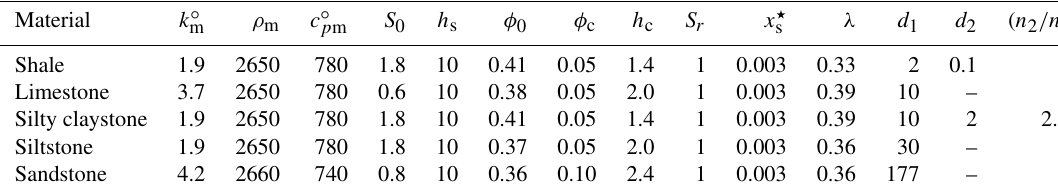
Table 5. Thermophysical parameters for the sedimentary rock units in Fig. 8. Parameters include thermal conductivity of matrix particles at 0 ◦ C, k ◦ m (Wm − 1 K − 1 ); density of matrix particles, ρ m (kgm − 3 ); specific heat of matrix particles at 20 ◦ C, c ◦ p m (Jkg − 1 K − 1 ); heat- production rate extrapolated to surface, S 0 (µWm − 3 ); heat-production length scale, h s (km); porosity extrapolated to surface, φ 0 ; critical porosity, φ c ; compaction length scale, h c (km); degree of pore saturation, S r ; solute mole fraction in the fully melted system, x (cid:63) s ; interfacial melting parameter, λ (µmK 1 / 3 ); effective diameter of larger mode pores, d 1 (µm); effective diameter of smaller mode pores, d 2 (µm); ratio of the number density of small pores to large pores, n 2 /n 1 .